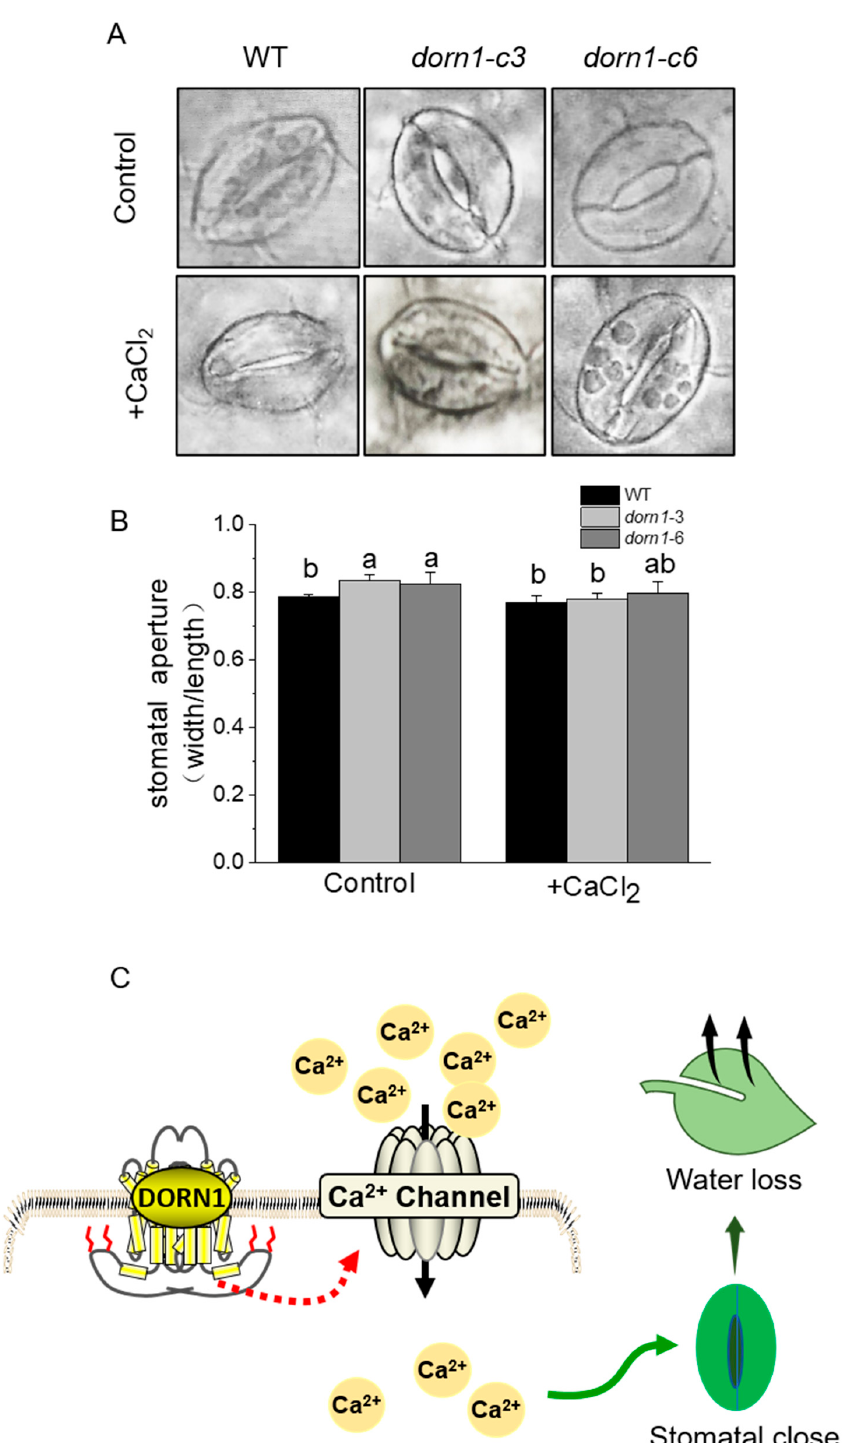
Figure 6. Effects of CaCl 2 on stomatal aperture. ( A ) Stomatal phenotype analysis of the plants with or without 1 mM CaCl 2 treatment, for the treatment group, plants were pre-treated by spraying 1 mM CaCl 2 one hour before decoloring. ( B ) Statistical analysis of the stomatal aperture (width/length). Different letters indicate significant differences ( p < 0.05) using ANOVA analysis. Each data point represents the average stomatal aperture of ~15 seedlings of three duplicate experiments, and error bars represent standard deviation (SD). ( C ) A possible working model for DORN1 in drought tolerance in plants.